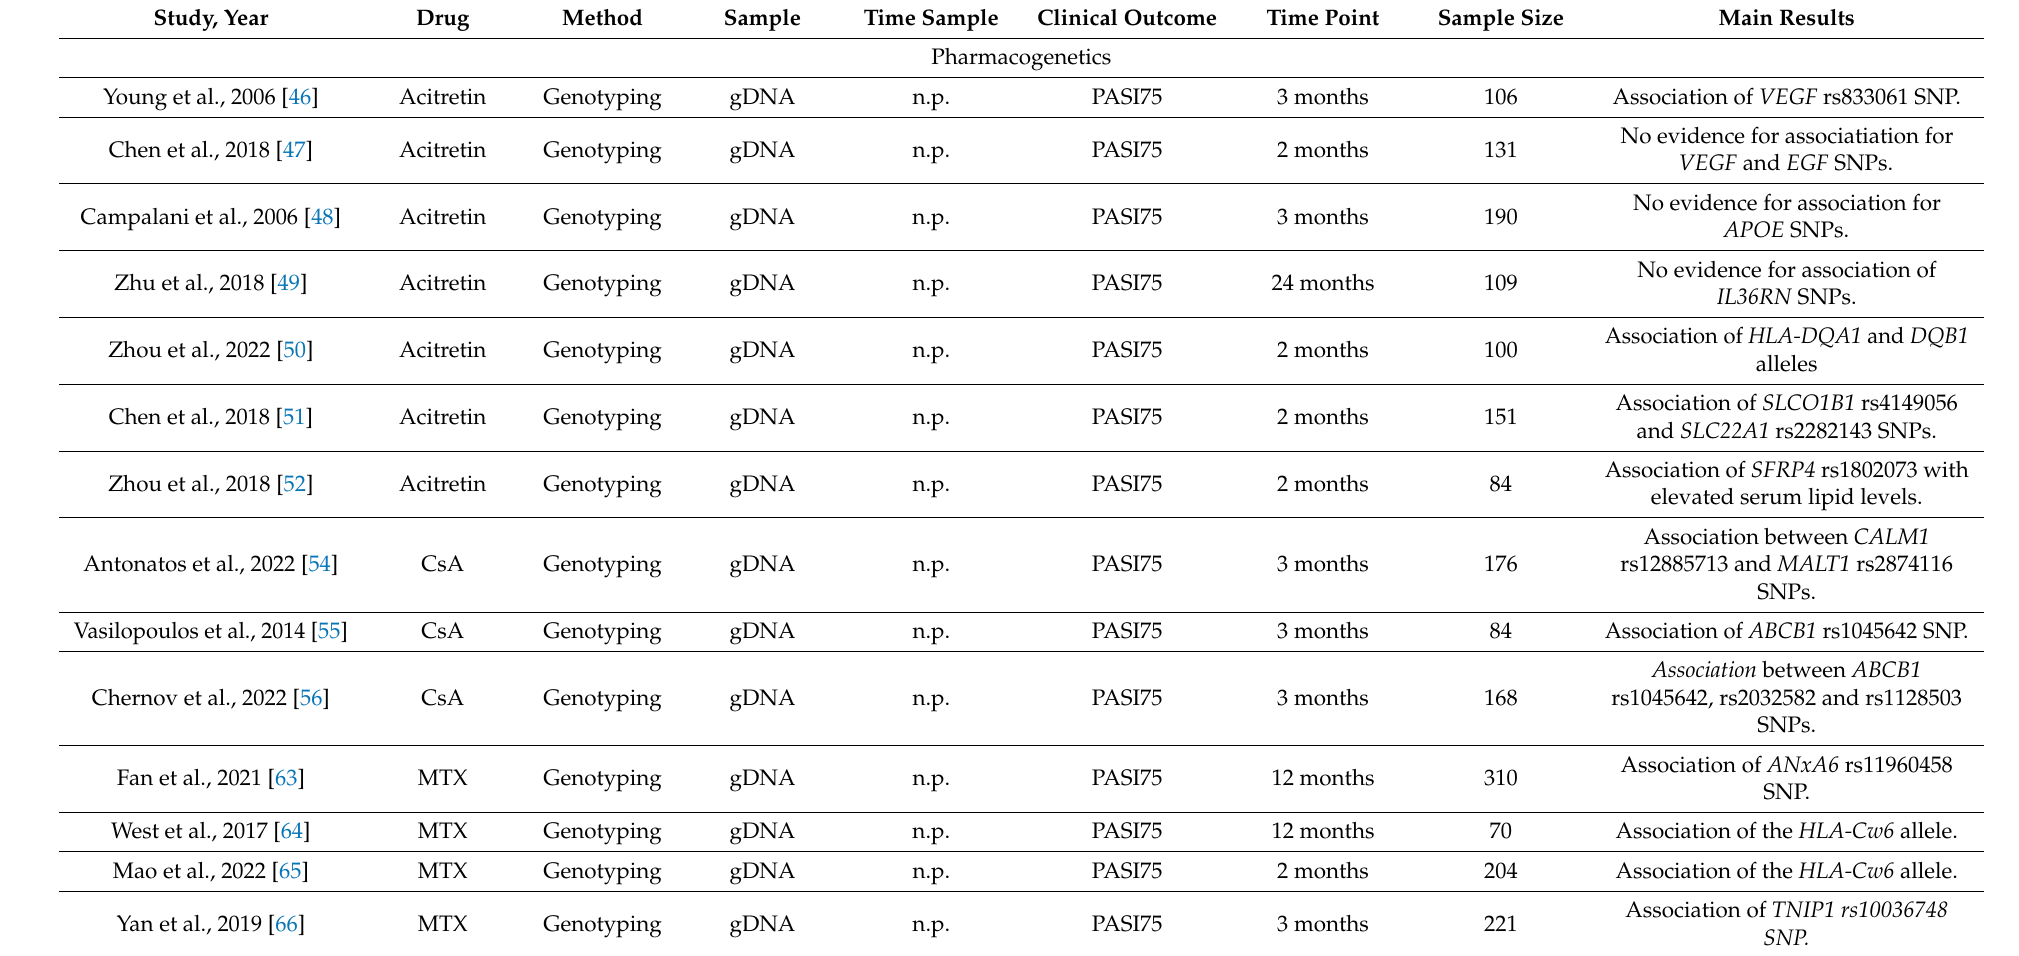
Table 1. Pharmaco-omic approaches applied in conventional